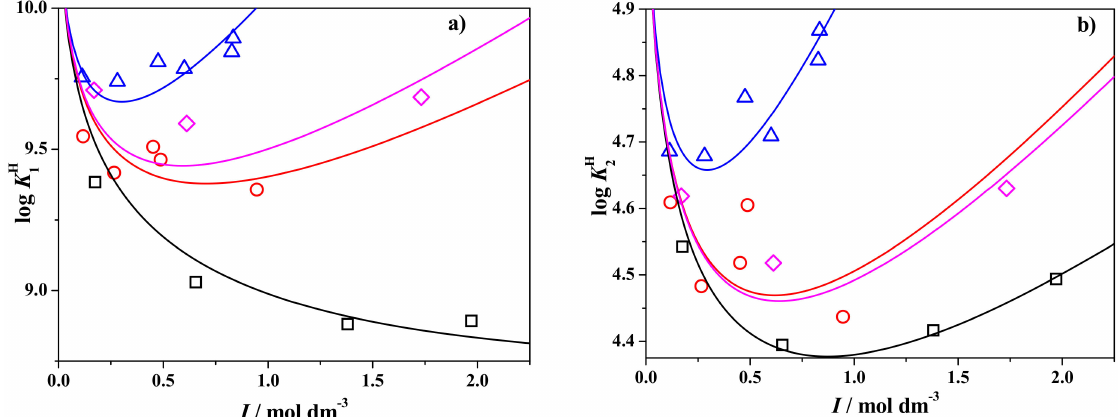
Figure 1. Dependence of the first ( a ) and second ( b ) protonation constants of GLDA on ionic strength at T = 298.15 K in NaCl aq ( (cid:3) ), KCl aq ( ), (CH 3 ) 4 NCl aq ( ♦ ) and (C 2 H 5 ) 4 NI aq ( ∆ (cid:35)